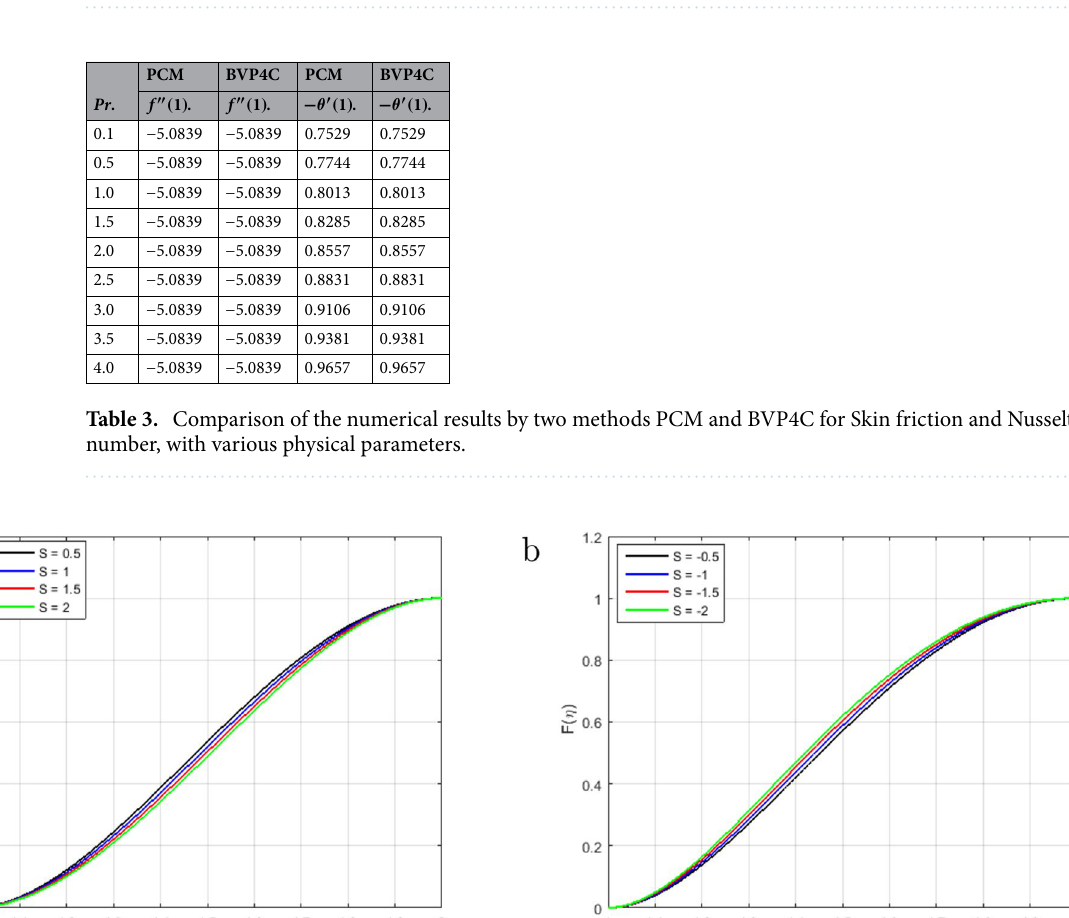
Table 2. Comparison of the numerical results by two methods PCM and BVP4C for Skin friction and Nusselt number, with various physical parameters.